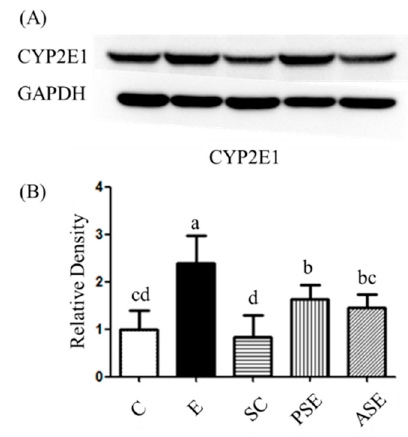
Figure 2. Effects of synbiotics on hepatic cytochrome P 450 2E1 (CYP2El) protein expression in rats with chronic ethanol feeding. ( A ) Western blot analysis of CYP2E1 protein expression. Glyceraldehyde 3-phosphate dehydrogenase (GAPDH) was used as internal control. ( B ) Quantitative analysis of protein levels and the ratio of each internal control was calculated by setting the value of the mean of the C group. Bars are the mean ± standard deviation ( n = 6). Different letters indicate a significant difference at p < 0.05 by a one-way ANOVA with Duncan’s post-hoc test.